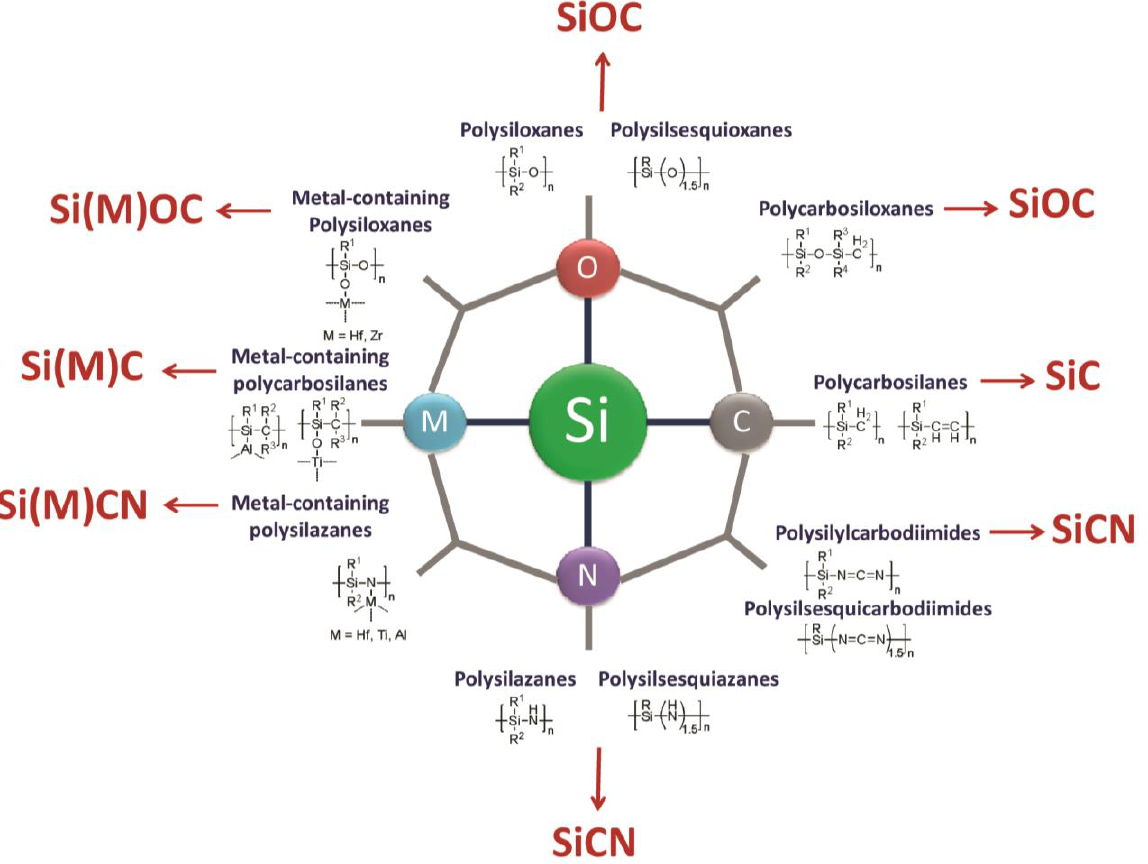
Figure 1. Typical classes of organosilicon polymers used as precursors for ceramics (reprinted with permission from Wiley)